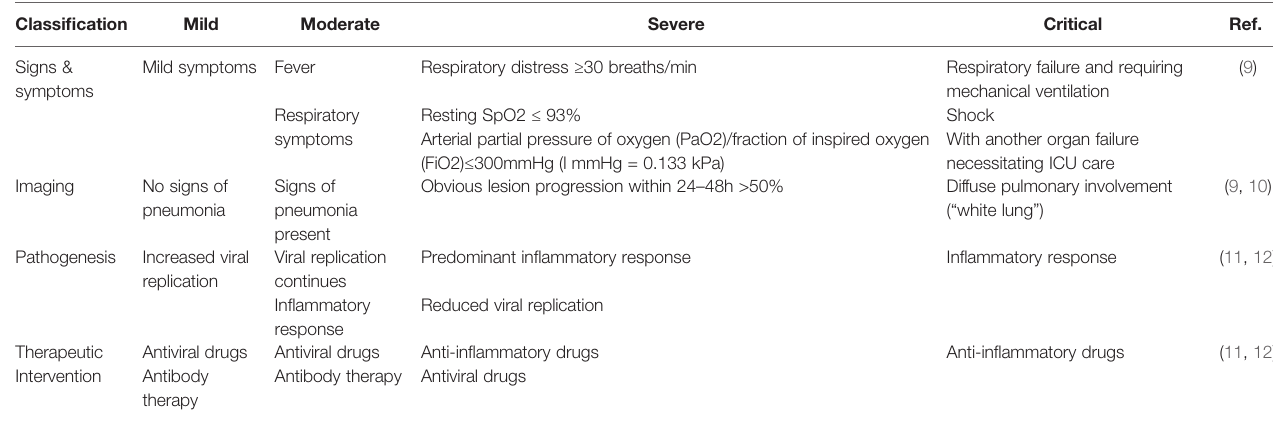
TABLE 1 | Classi fi cation of